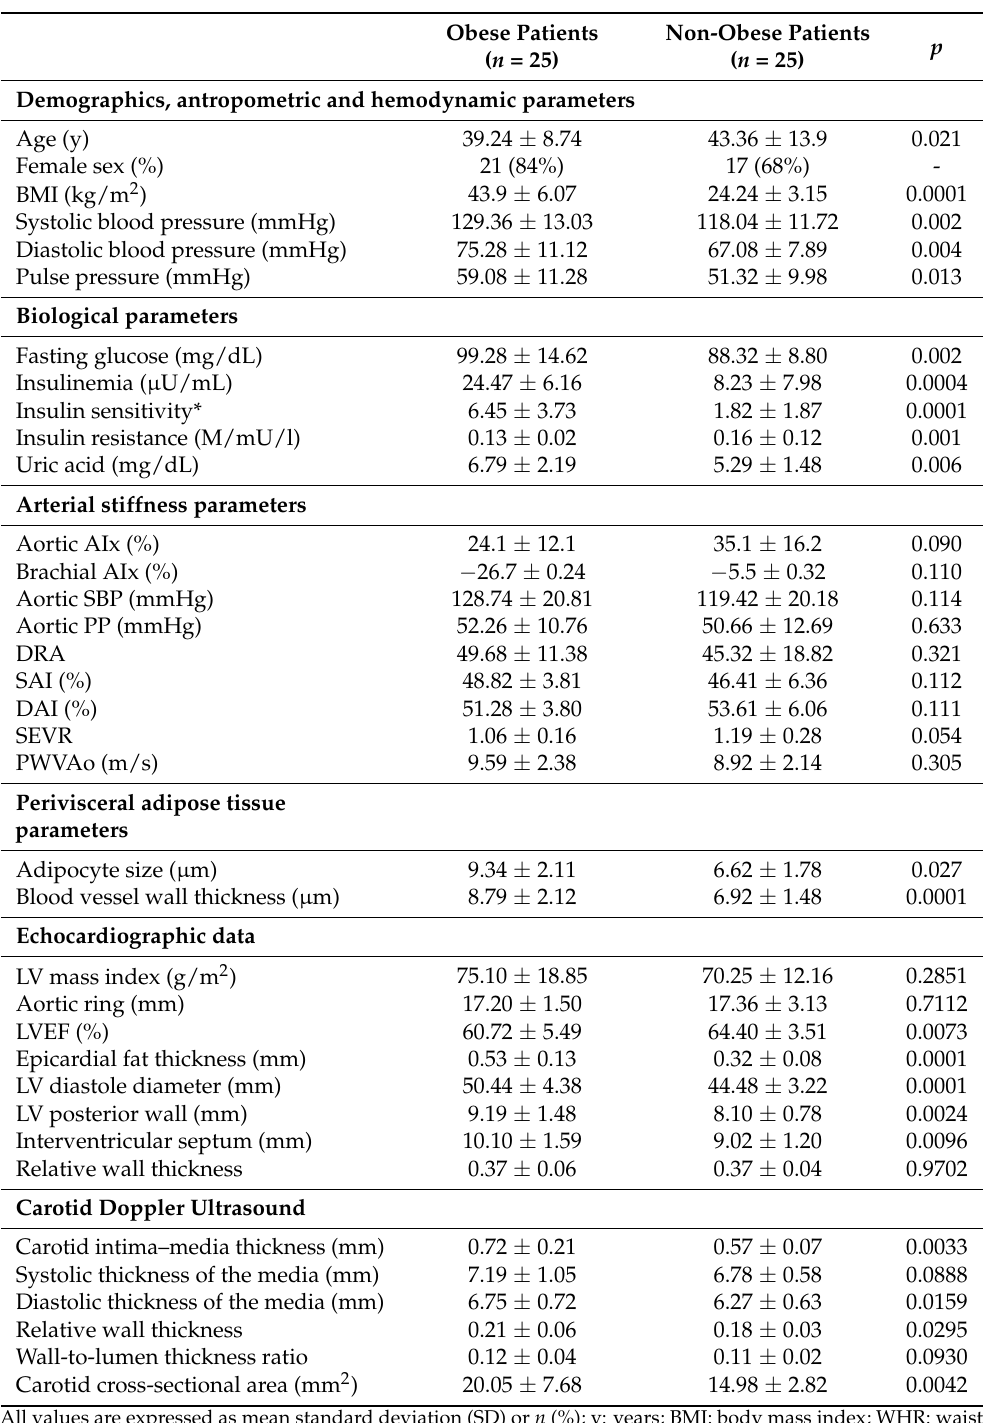
Table 1. Demographics, anthropometric and paraclinical parameters included in the statistical